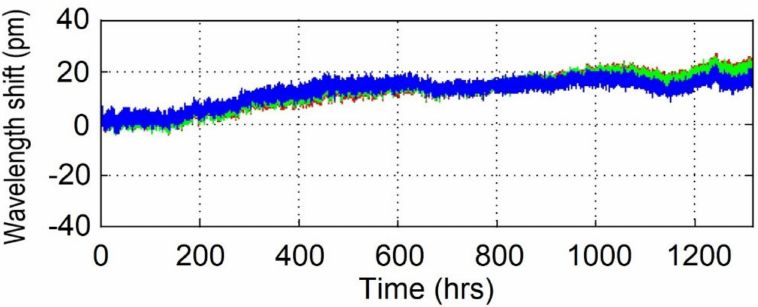
Figure 8. Bragg wavelength drift of 3 Type II FBGs at 650 ◦ C over 1300 h (reproduced from [54]). In another experiment [55], an 80 fs Ti-sapphire regenerative amplifier operating at a central wavelength of λ = 800 nm was used to inscribe π -shifted Type II FBGs in SMF-28 using a π -shifted phase mask with a period of 3.21 µ m. To test how the FBGs responded to high temperature annealing, a number of devices were temperature-cycled many times inside a tube furnace from 20 ◦ C to 1000 ◦ C in ambient air. During this testing (Figure 9), the FBGs remained in the furnace at 1000 ◦ C for more than 200 h. The the π -passband features in the spectra of all the FBGs tested at 1000 ◦ C drifted toward longer wavelengths by 150–200 pm with an average drift rate being ~4 pm/h during the first 50 h of annealing, ~1 pm/h during the following 80 h and <0.1 pm/h during the remaining hours of the experiment.